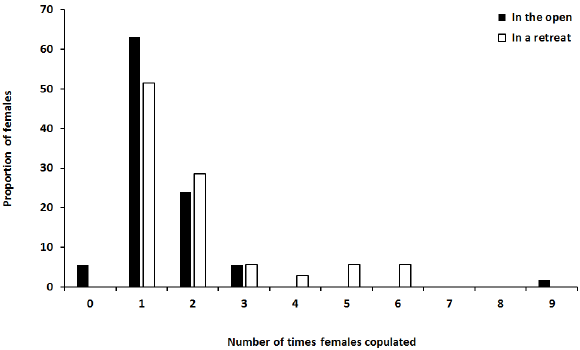
Fig 3. Number of times that female Servaea incana mated over a lifetime of repeatedexposureto males (a) in the open ( N = 54) and (b) in a retreat ( N = 35).